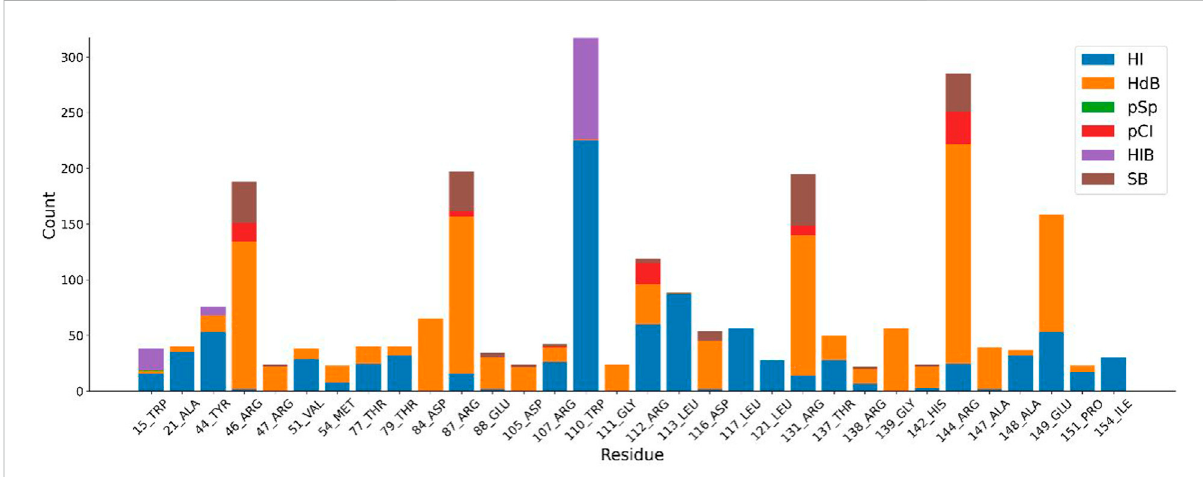
Differentaminoacidbindingmodes.Bluerepresentshydrophobicinteractions(HI),orangerepresentshydrogenbonds(HdB),greenrepresents π - π stacking (pSp), red represents π -cation interactions (pCI), purple represents halogen bonds (HIB) and brown represents salt bridge (SB).